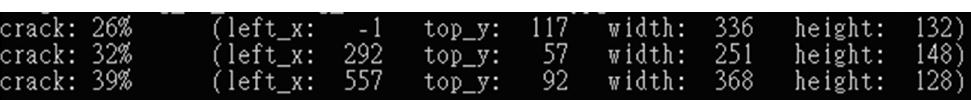
Figure 16. Coordinates and parameters of the bounding boxes.